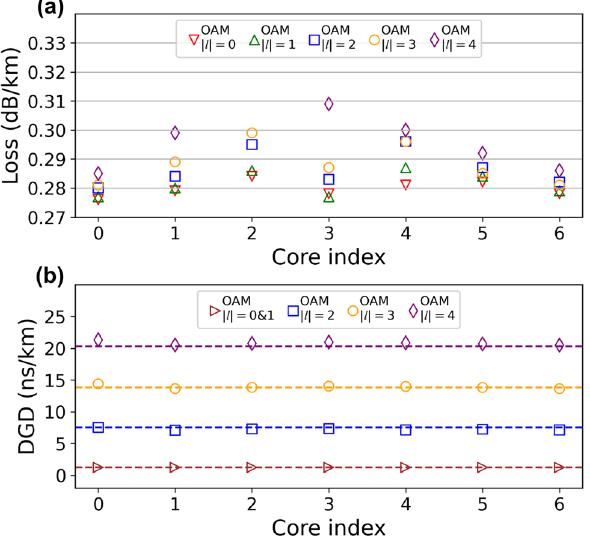
Figure 2: The characterization of the fabricated seven-core RCF. (a) Measured propagation loss of all MGs at 1550 nm along with the fabricated seven-core RCF. The loss of OAM MG | l | = 4 for core 2 is 0.36 dB/km and is much higher than other MGs due to the fi bre fabrication errors, and is dismissed in this fi gure. (b) Measured differential group delays (DGDs) of all guided modes of the fabri- cated seven-core RCF at 1550 nm. Dashed lines represent the simulated